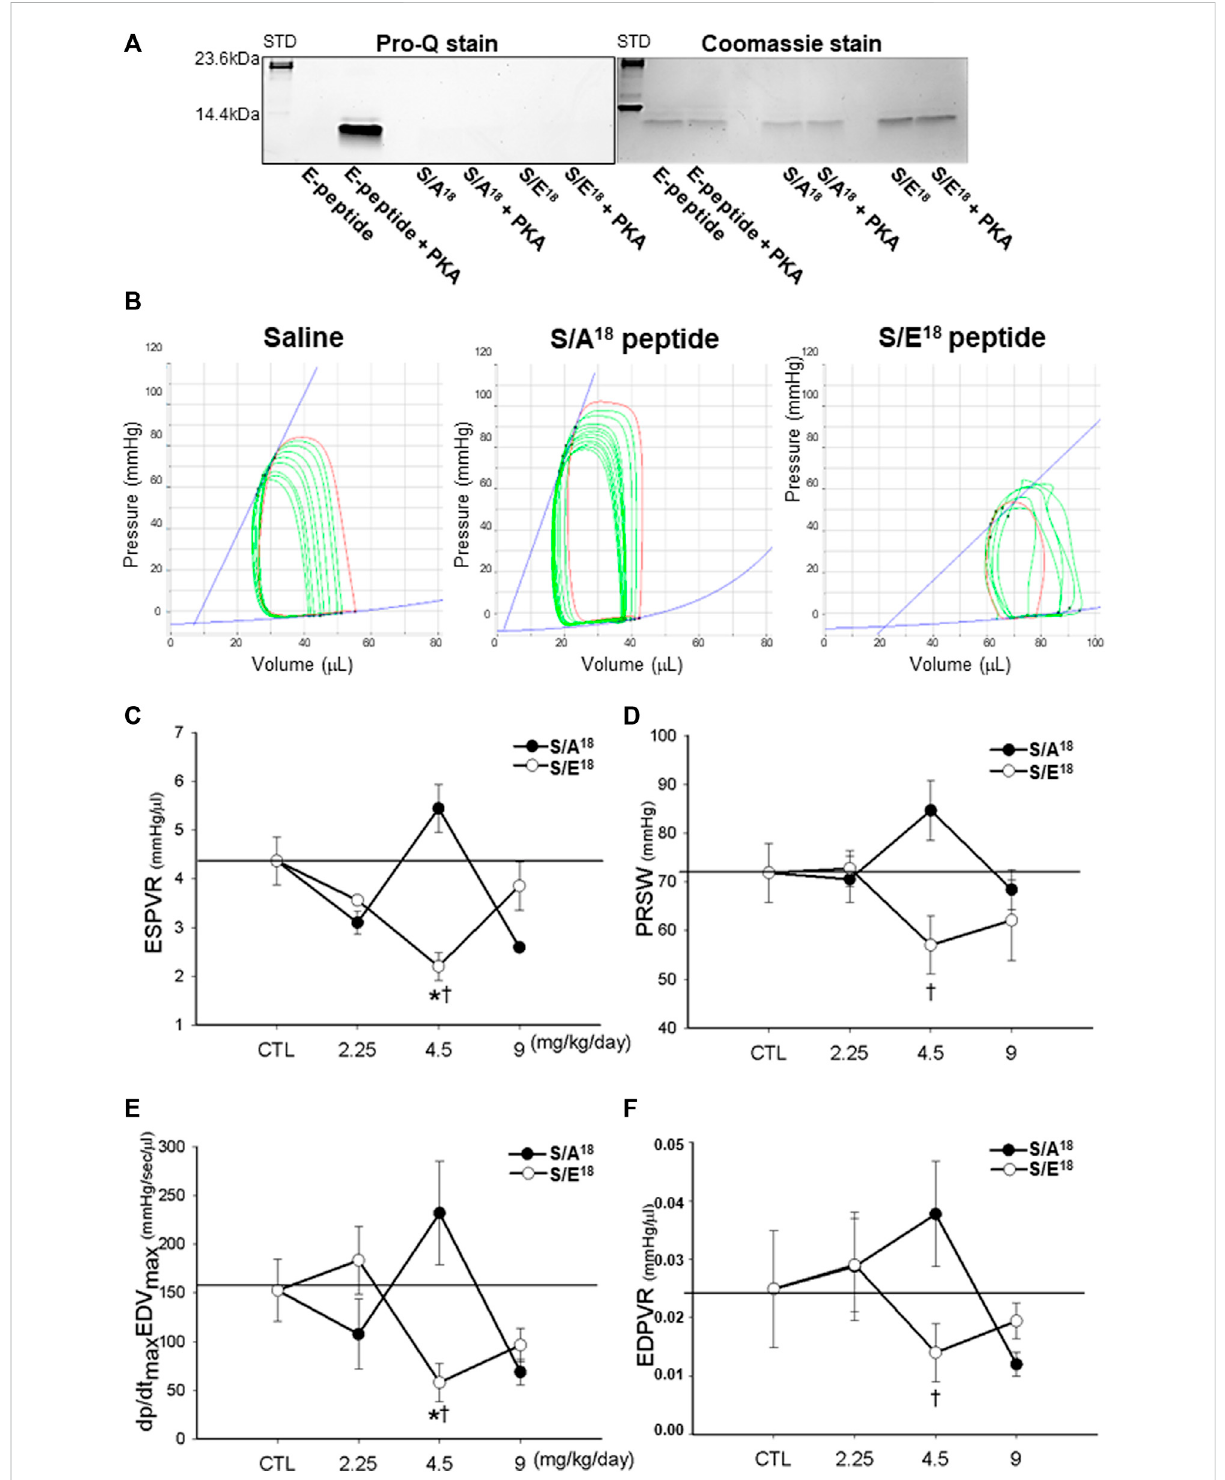
FIGURE 2 E-domain phosphorylation and measurements of contractility in the hearts of phospho-null and phosphomimetic peptides treated mice. (A) . PKA phosphorylation of the native E-domain peptide, phospho-null and phosphomimetic peptides in vitro. (B) . Representative P-V loops following inferior vena cava occlusion in the hearts of peptide treated mice at 4.5 mg/kg/day dose. (C) . ESPVR-end systolic pressure volume relationship. (D) . PRSW-preload recruitable stroke work. (E) . Maximum dP/dt vs maximum EDV. (F) . EDPVR-end diastolic pressure volume relationship. ( *p < 0.05 vs. CTL and † p < 0.05 vs. peptide at same dose, n =